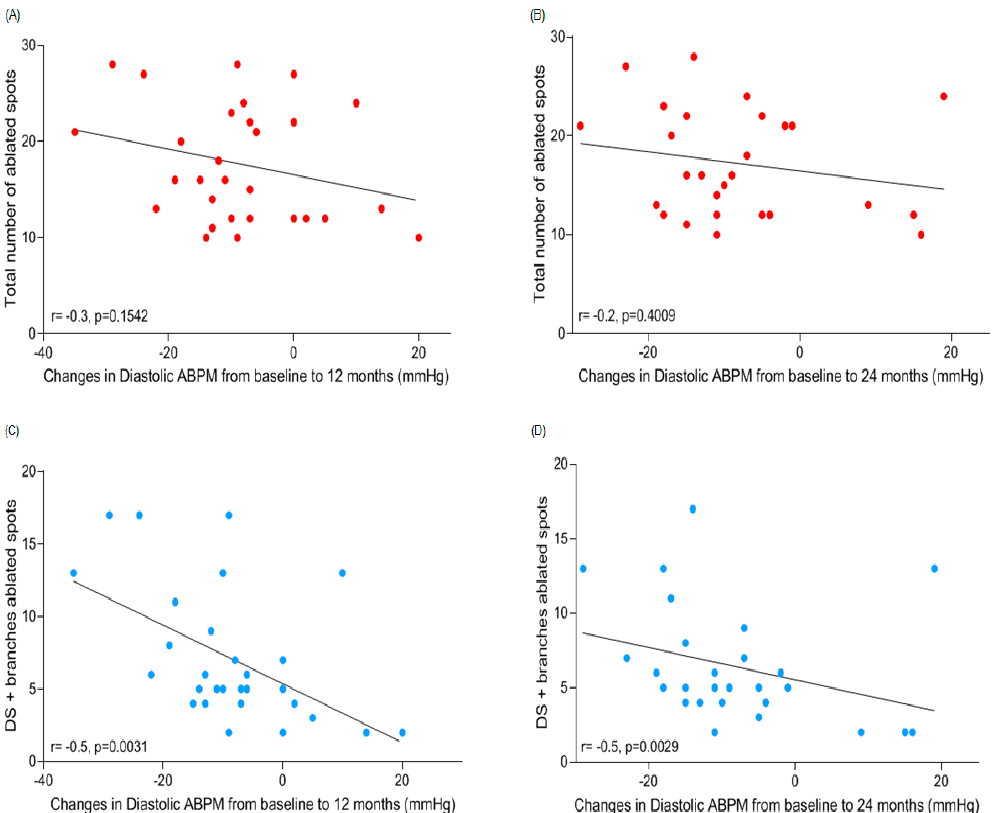
Figure 4. Correlations between changes from baseline to 12 and 24 months of follow-up in ambulatory diastolic blood pressure after renal denervation and ( A , B ) number of ablated spots in total (red dots) and ( C , D ) distal segment summed to branches (light green dots) of renal arteries. ABPM = ambulatory blood pressure monitoring. DS = distal segment. Correlations for the number of treatments performed in the distal segment and branches were significant at both time points.